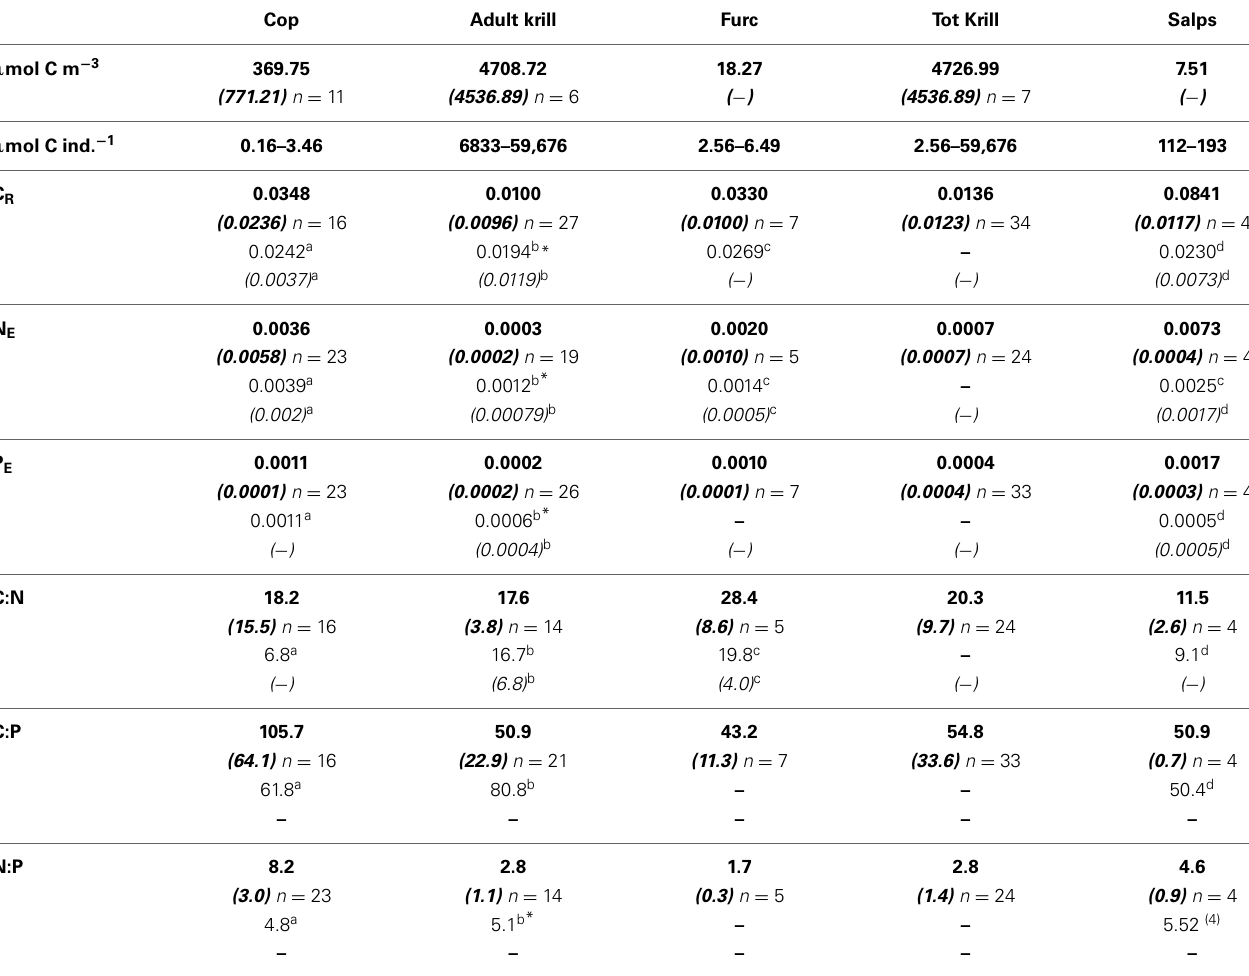
Table 2 | Average values and standard deviation (in italics between brackets) of biomass ( µ mol C m − 3 ), individual biomass range ( µ m C ind − 1 ), C- specific metabolic rates (C R , carbon respiration, d − 1 ; N E , ammonia excretion, µ mol NH 4 -N µ mol C − 1 d − 1 ; P E , µ mol PO 4 -P µ mol C − 1 d − 1 ), and C:N, C:P and N:P metabolic ratios by atoms for the studied zooplankton